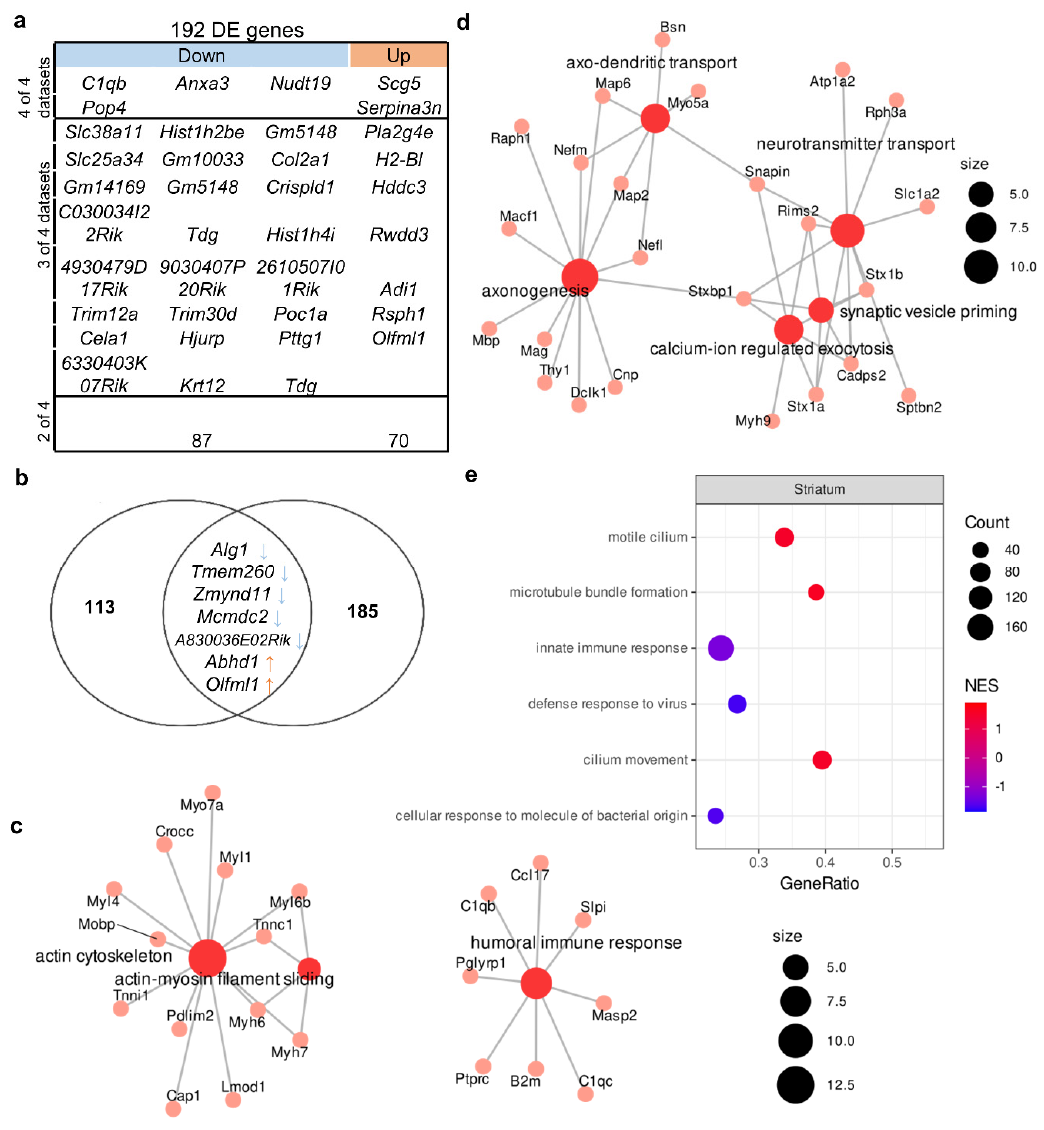
Figure 3. Molecular signatures in the corticostriatal area of BTBR mice. Out of a total of 192 DE genes, 4 were downregulated in all 4 datasets, and 24 were downregulated in 3 out of 4 and 87 in 2 out of 3. In all datasets, 2 genes were upregulated, 7 genes were upregulated in 3 out of 4 datasets, and 70 were upregulated in 2 out of 4. ( a ) The comparison of DEGs from the corticostriatal area. ( b ) The overlap between the set of genes carrying a high-prediction-score mutation and the set of DEGs. Out of 120 “high prediction score” genes, only 7 overlapped with reproducible DE genes set (192 gene). ( c ) The GO category enriched in the set of DEGs. Size of the node represents number of genes in the category. ( d ) GO categories enriched in the set of differentially expressed proteins on the basis of data from Ref. [43]. Size of the node represents number of genes in the category. ( e ) Top three up- and downregulated GSEA categories in the set of all expressed genes according to the reanalysis of GSE138539 data. NES: normalized enrichment score. Size of the circle (count) represents number of genes in the category, color of the circle represents normalized enrichment score (NES).